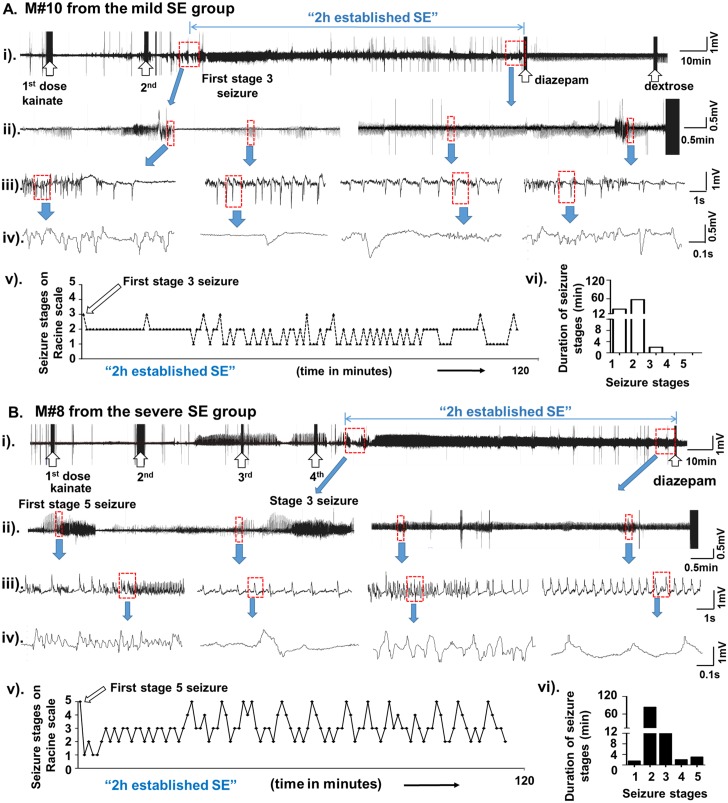
A (i to iv) and B (i to iv) are the representative EEG traces obtained during mild and severe SE, respectively, in this study.The behavioral scoring (Racine scale stages from 1 to 5) for these mice during the 2 hours established SE (v) and the duration of each stage was quantified (vi). The upward open arrows indicate the injections given [kainate (5 mg/kg)- first two arrows in A (i), and first four arrows in B (i); diazepam and dextrose at the other end of the trace]. The first episode of stage-3 seizure in the mild SE group (A, after the second dose of kainate) or the stage 5 in the severe SE group (B, after the fourth dose of kainate) is shown on the EEG traces (i and ii). The expanded EEG trace from the very end of the established SE, prior to the diazepam treatment, is shown in the panel (ii). A further expanded EEG traces are also shown in panels (iii) and (iv). The first stage 3 (in mild group) or the stage 5 (in the severe group) marked the beginning of the 2 hours established SE. During the 2 hour period, the mouse [panel A, (v)] had stage 2 seizures continuously for first 30 minutes with a second episode of stage-3 seizure half-way through and changed to the stage-1 seizure. Beyond this point, the remaining 90 minutes, the mouse (panel A) had continuous seizures ranging from stage-1 to stage-3. The exact amount of time spent at each stage is given in the panel (vi), likewise for the mouse in the severe SE group (panel B). During the 2 hour period, the mouse (panel B) had a brief stage-1 seizures followed by continuous stage 2–5 seizures during the remaining period of 2 hours (v). The exact amount of time the mouse spent at each stage is given in the panel vi.